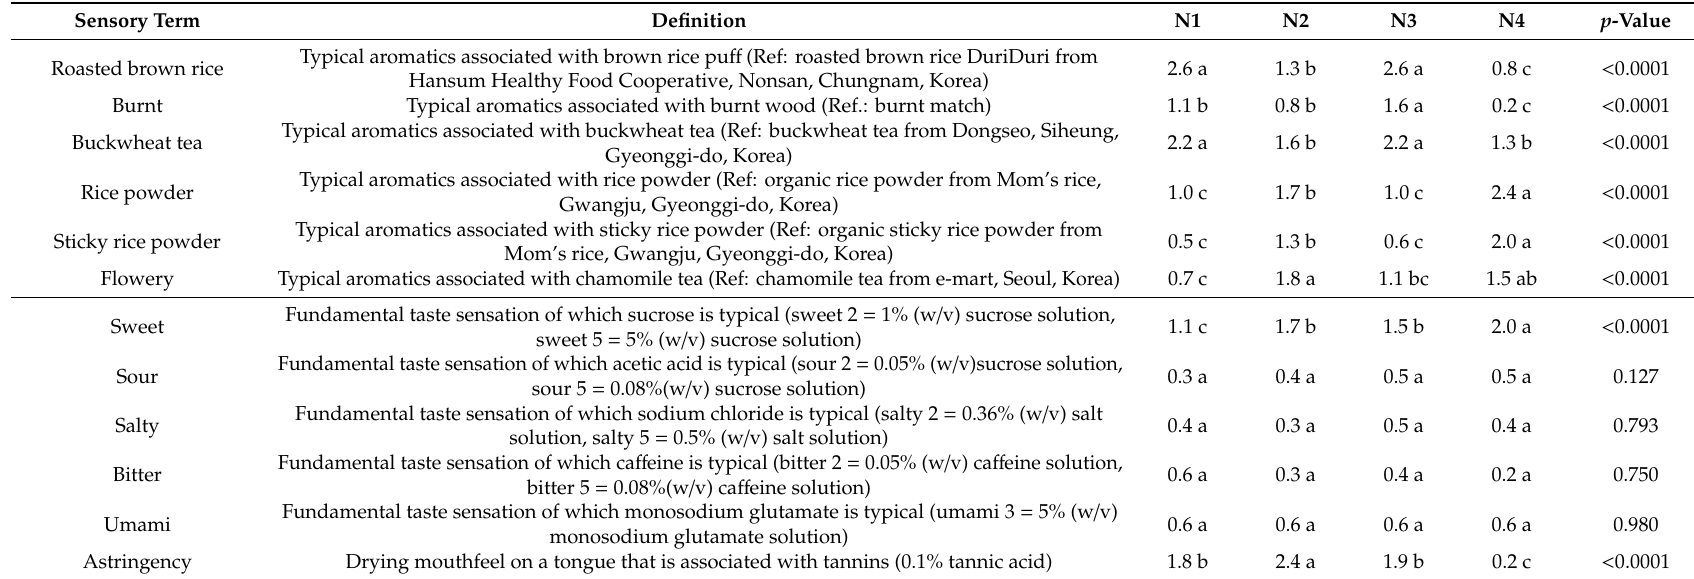
Table 3. Descriptive sensory flavor analysis results on Nuroongji samples.